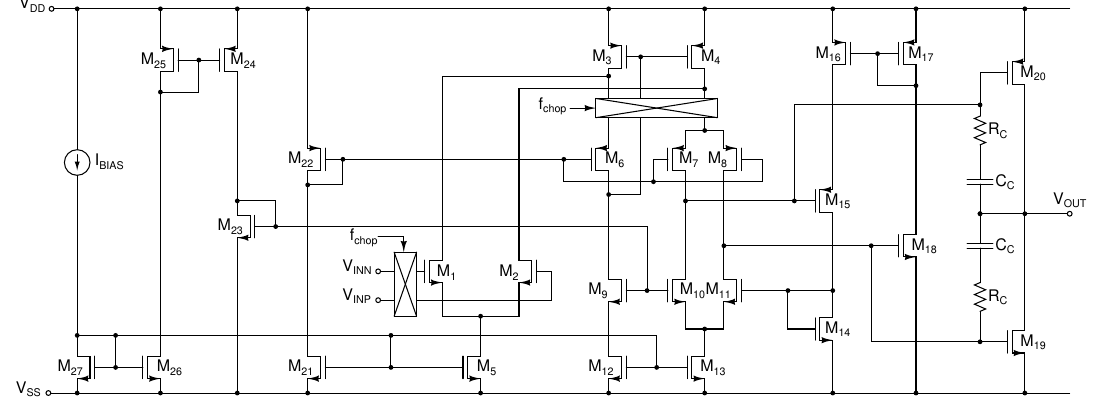
Figure 5. Schematic of the Class AB op-amp used to implement the TIA and the programmable gain amplifier